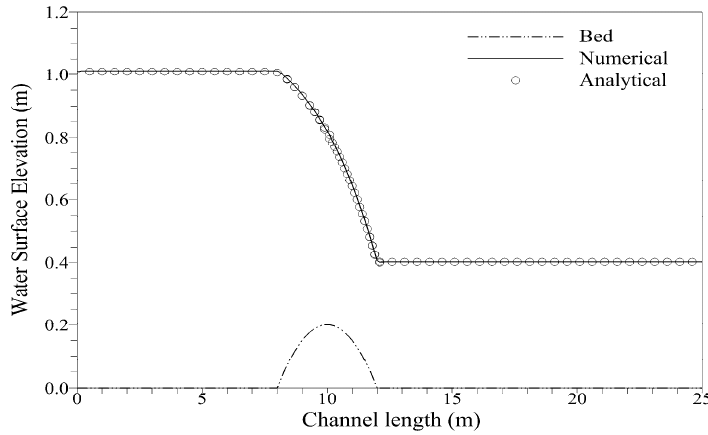
Figure 8. Comparison of water surface elevation ( a ) and discharge ( b ) for transcritical flow with a shock.